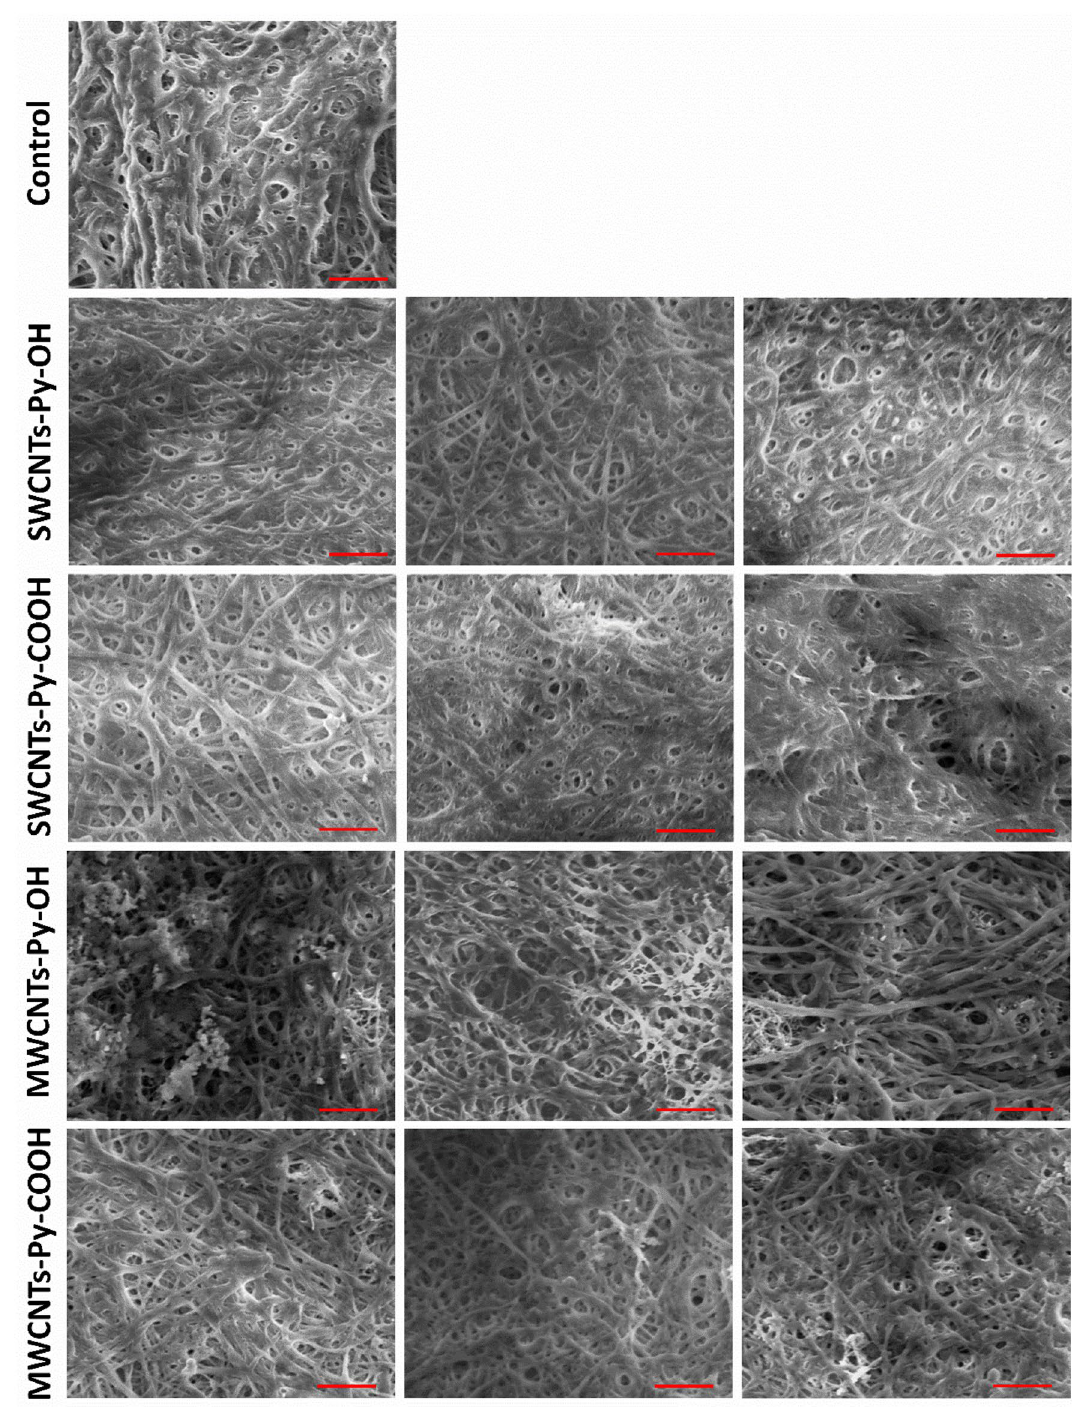
Figure 13. SEM images for collagen-based ECTs containing different concentrations of SWCNT and MWCNT species; Left: 0.025%, middle: 0.050%, right: 0.100%. Scale bar = 1